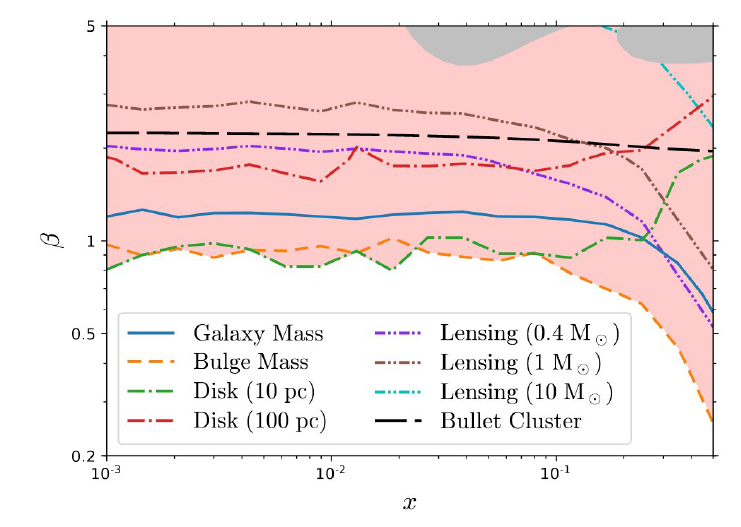
Figure 9: Constraints on the ratio β of mirror baryons to visible baryons versus x = ξ = T (cid:48) / T from structure formation in models with perfect mirror symmetry, from Ref. [ 64 ] . β is related to f , the fraction of atomic DM, by f = β Ω